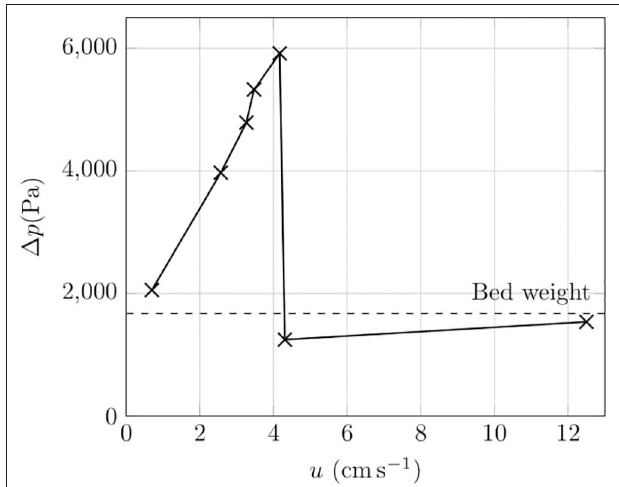
FIGURE 10 | Change of pressure drop over a two-layer bed as u is incremented. The sudden fall in pressure corresponds to the point at which breakthrough takes place. The total bed thickness was 10cm and the bed layers conformed to r = 2.44 in Table 2 . The dashed line is the bed weight